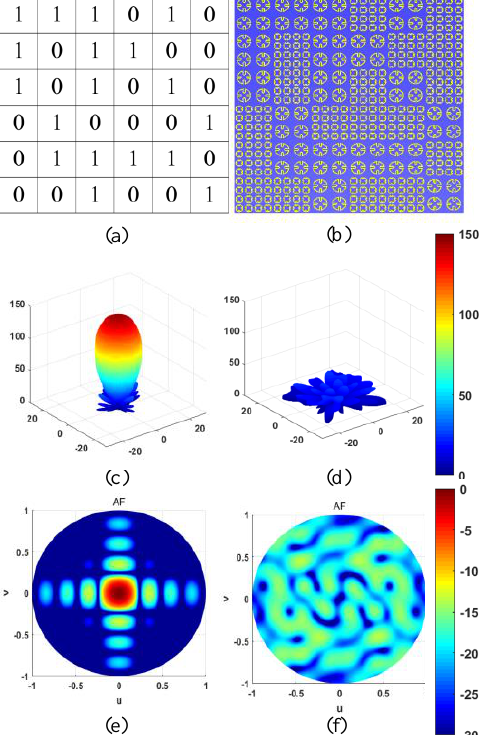
Figure 4. Matrix arrangement and calculated scattering fields. ( a ) Schematic diagram of super cells. ( b ) The sequence of the coding metasurface sample, with scattering fields calculated at the center frequency of 18 GHz. ( c , d ) Scattering 3D patterns of the uniform coding matrix and the optimal coding matrix, respectively. ( e , f ) Scattering fields on the wave vector domain of the above two matrixes, respectively. (AF: a composite signal formed by coherent superposition of the signals on the array after being received by each array element).